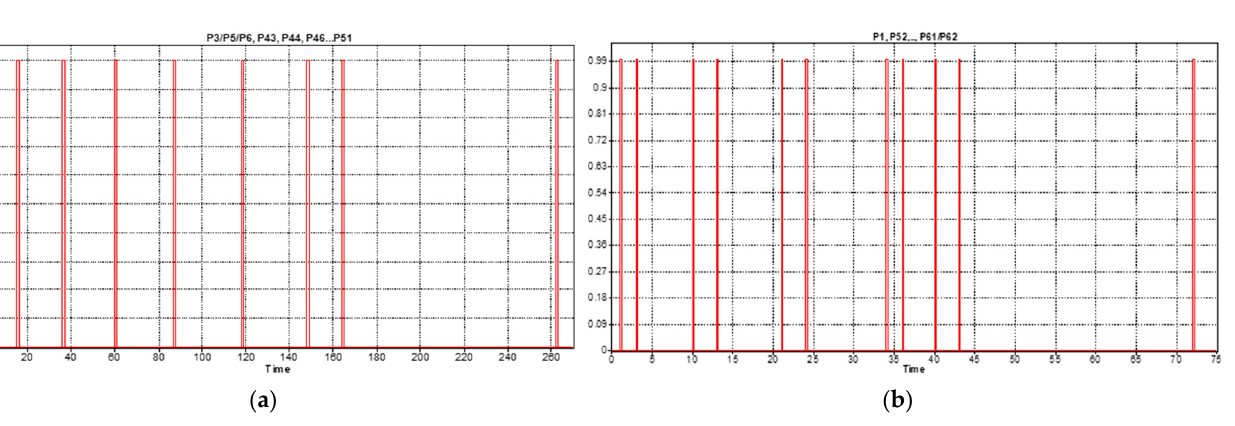
Figure 9. The monitoring signals of the successive actions for: ( a ) WP1 assembly; ( b ) WP2 assembly.